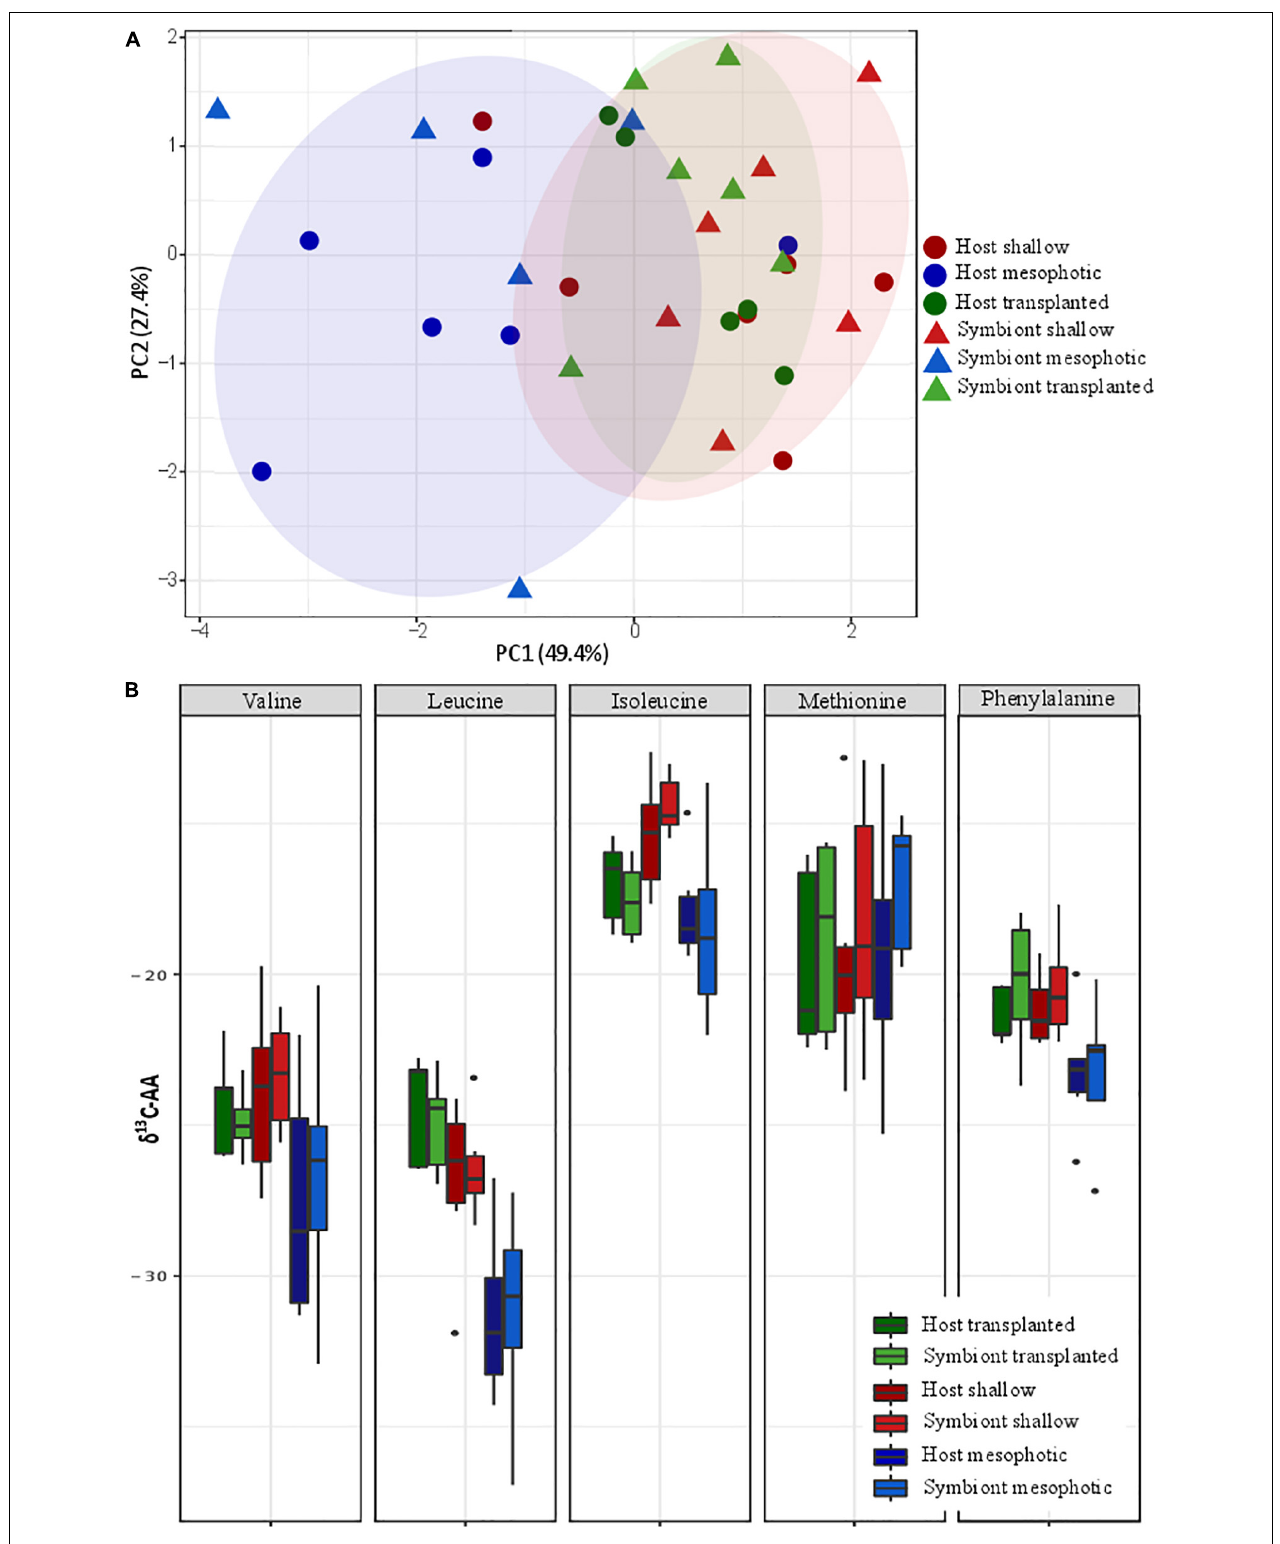
FIGURE 5 | Carbon source (A) carbon AA-CSIA PCA of five essential amino acids (valine, leucine, isoleucine, methionine, and phenylalanine). (B) Comparison of the different groups AA-CSIA results within each amino acid.